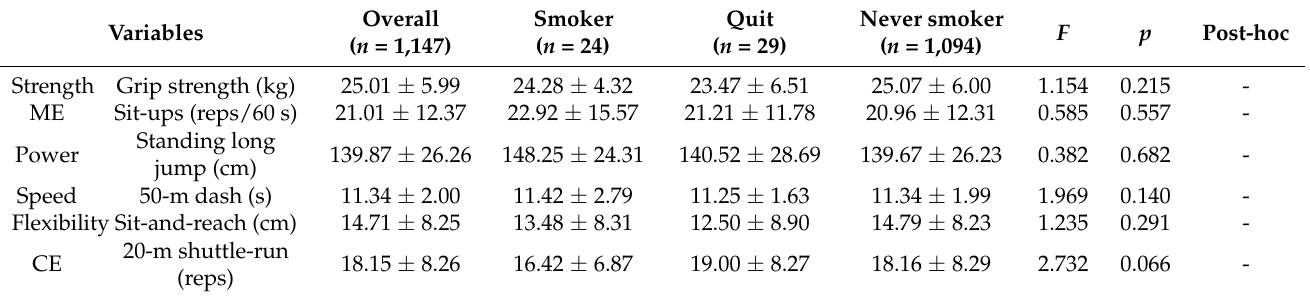
Table 3. Differences in physical fitness variables based on smoking in non-elderly adult women.